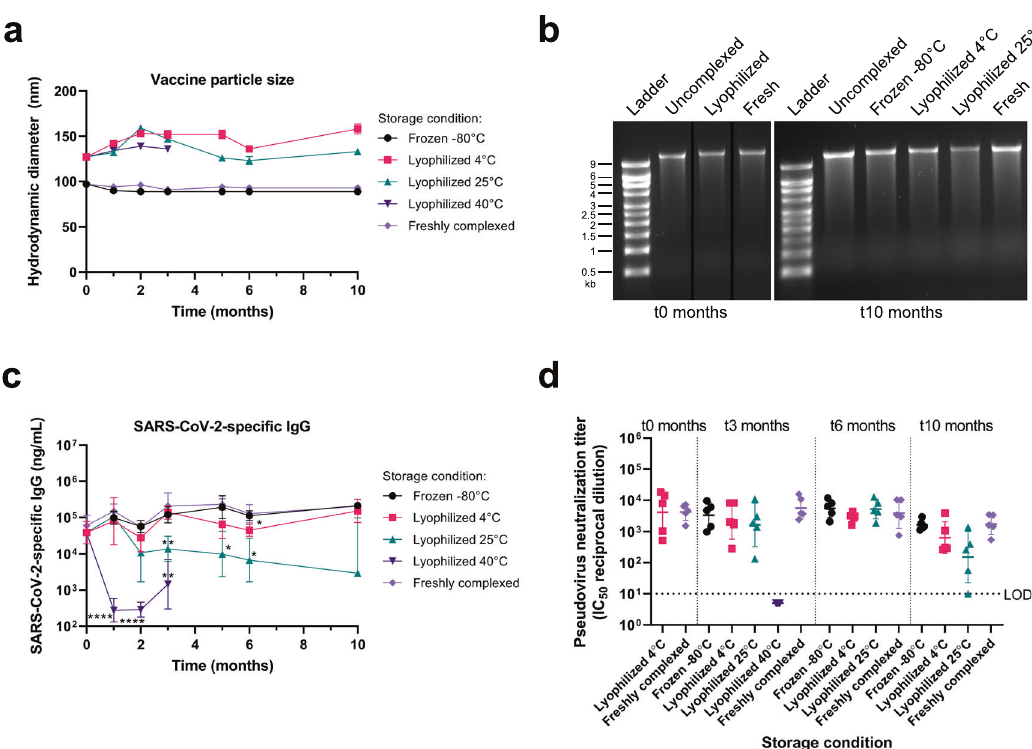
Fig. 6 Stability of the lyophilized SARS-CoV-2 saRNA/NLC vaccine (AAHI-SC2) after 10 months of storage at different temperatures. a Mean hydrodynamic (Z-average) diameter of the vaccine complex with error bars indicating the standard deviation (SD) of n = 3 replicate measurements for each condition at each timepoint. b Integrity of vaccine RNA at 0 and 10 months of storage at the indicated temperatures. “ Uncomplexed ” refers to saRNA alone that had been stored at − 80 °C for the indicated length of time. Lanes were derived from the same gel and re-arranged for the 0 months of storage image. See Supplementary Fig. 8 for original unprocessed gel images. c Serum SARS-CoV-2 spike protein-binding IgG induced in female C57BL/6J mice by the vaccine after storage under the indicated conditions for the indicated times. n = 5 mice per condition per timepoint. Antibody plots show geometric mean and geometric SD. Statistical analysis conducted on log- transformed data by Welch ’ s ANOVA test with Dunnett ’ s T3 multiple comparison test at each timepoint, comparing each stored vaccine preparation to freshly complexed vaccine. * p < 0.05, ** p < 0.01, **** p < 0.0001. d Pseudovirus neutralization titers induced in female C57BL/6 J mice by the vaccine after storage under the indicated conditions for the indicated times. LOD = limit of detection. n = 5 mice per condition per timepoint. Results show geometric mean and geometric SD. Statistical analysis conducted on log-transformed data by Welch ’ s ANOVA test with Dunnett ’ s T3 multiple comparison test at each timepoint, comparing each stored vaccine preparation to freshly complexed